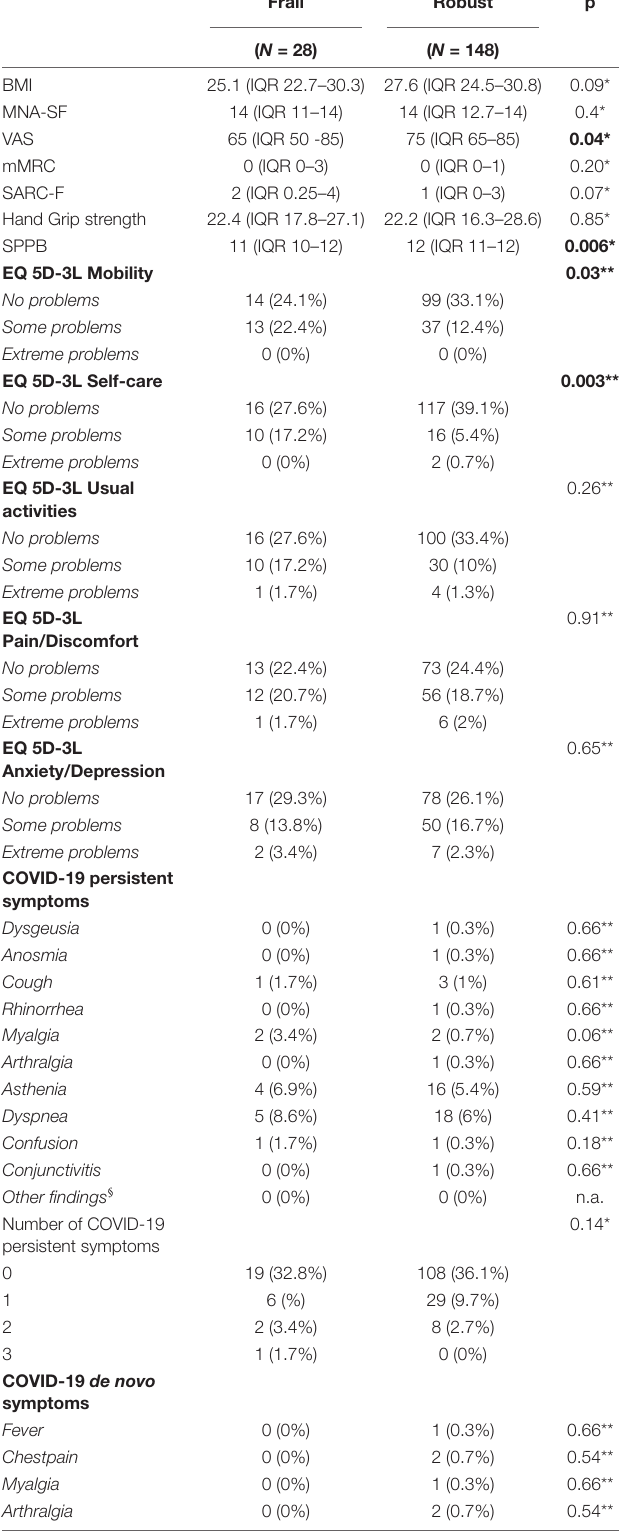
TABLE 4 | Nutritional and muscle characteristics, quality of life, and COVID-19 manifestations at the 6-month follow-up visits. Frail Robust